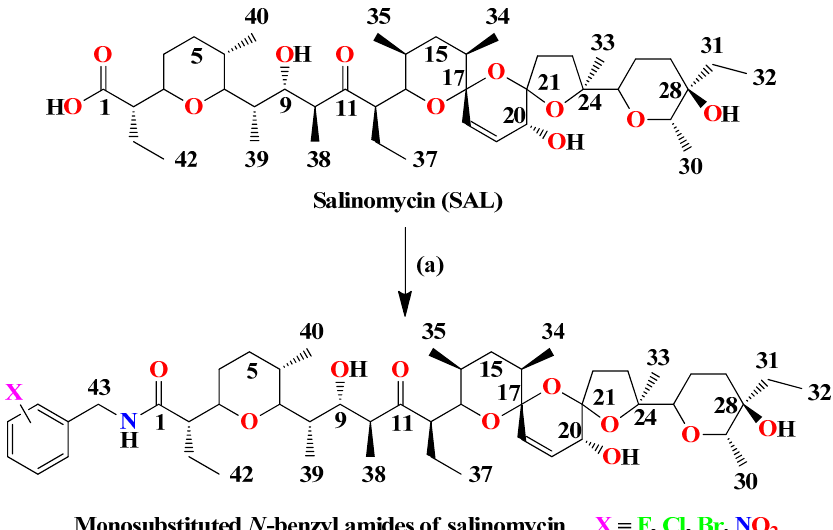
Figure 1. Synthesis of monosubstitued N -benzyl amides of